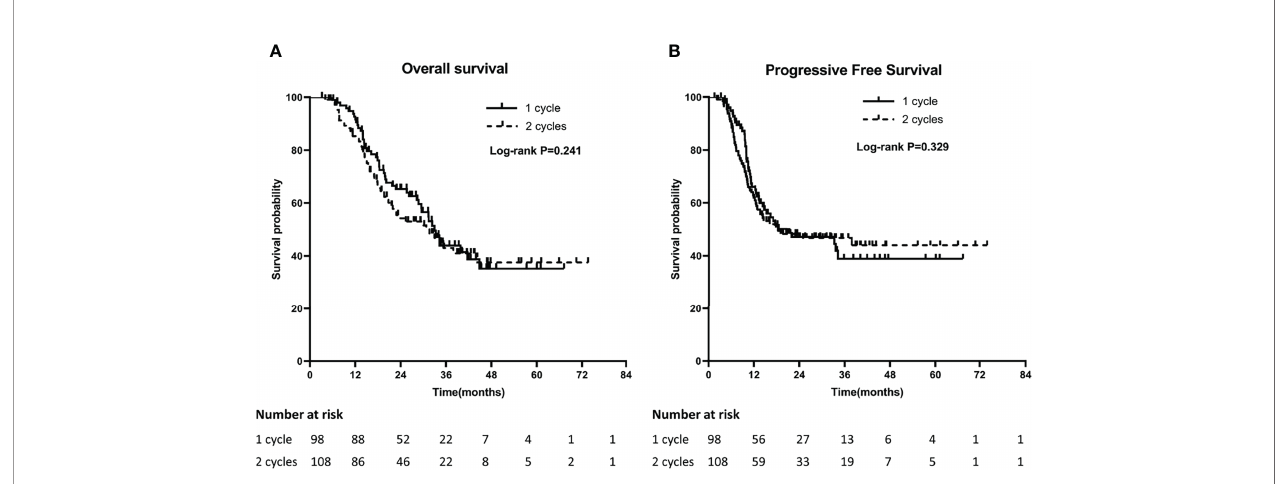
FIGURE 1 | Comparison of Overall survival (OS) (A) and Progression-Free Survival (PFS) (B) between 1 cycle and 2 cycle